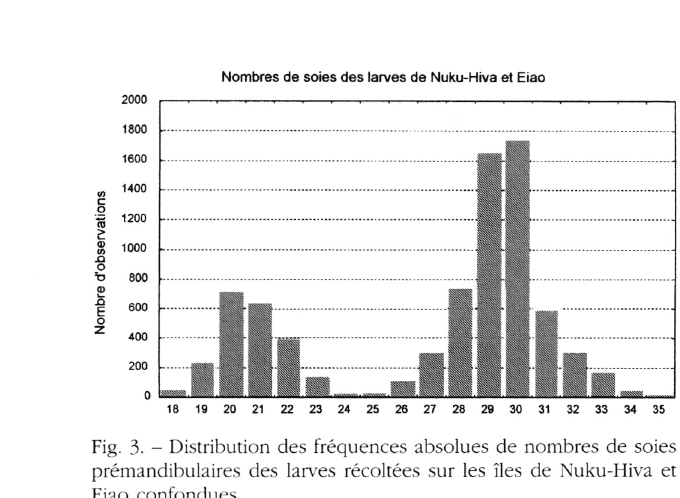
Fig. 3. - Distribution des fréquences absolues de nombres de soies prémandibulaires des larves récoltées sur les îles de Nuku-Hiva et Eiao confondues.